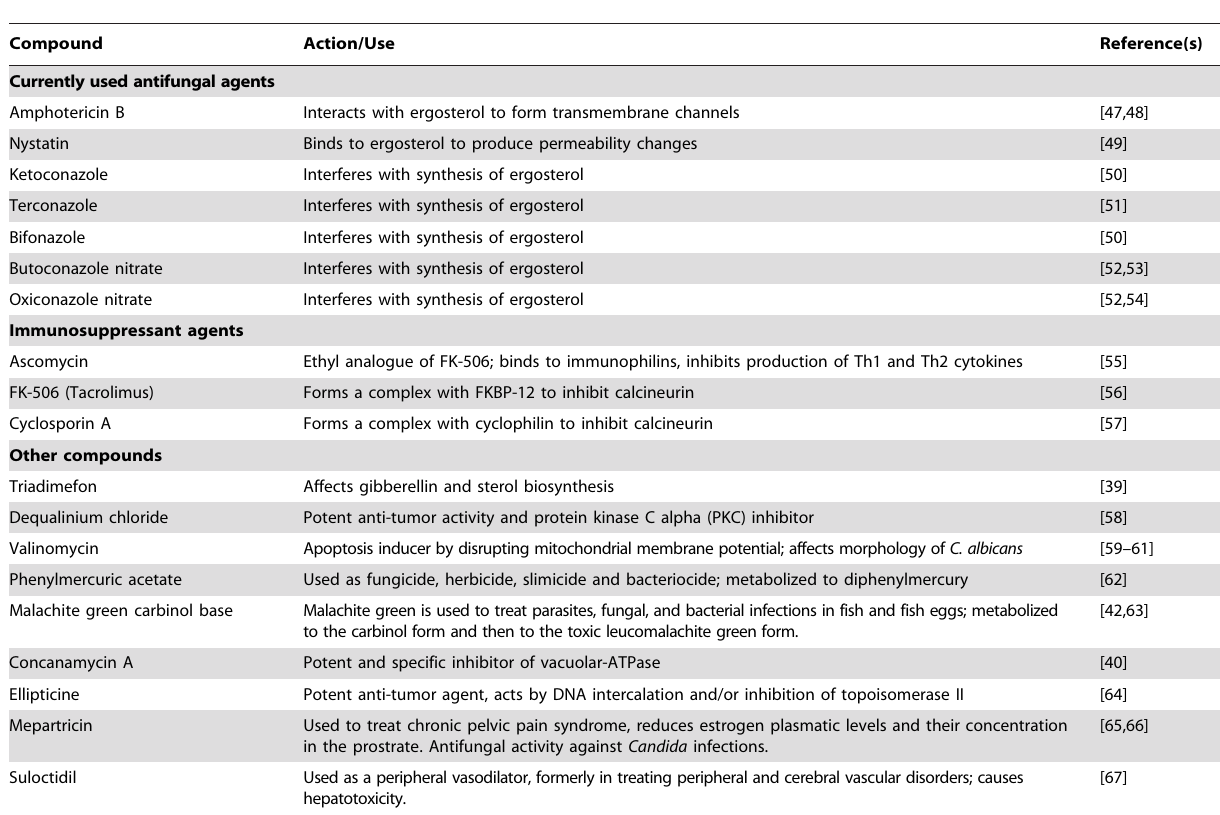
Table 1. Compounds exhibiting antifungal activity identified in the C. elegans – C. albicans infection assay.